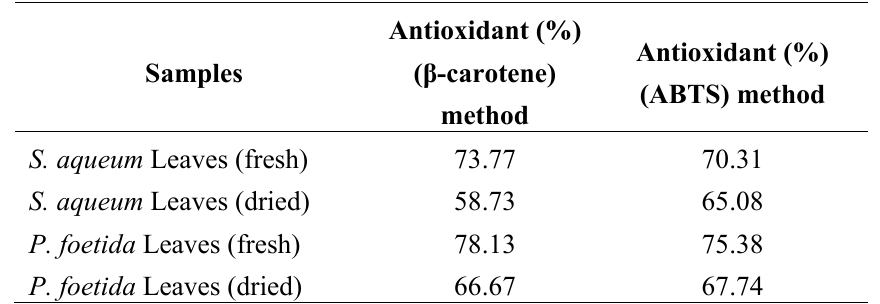
Table 2 . Comparison of oxidation (%) determination between oxidation β